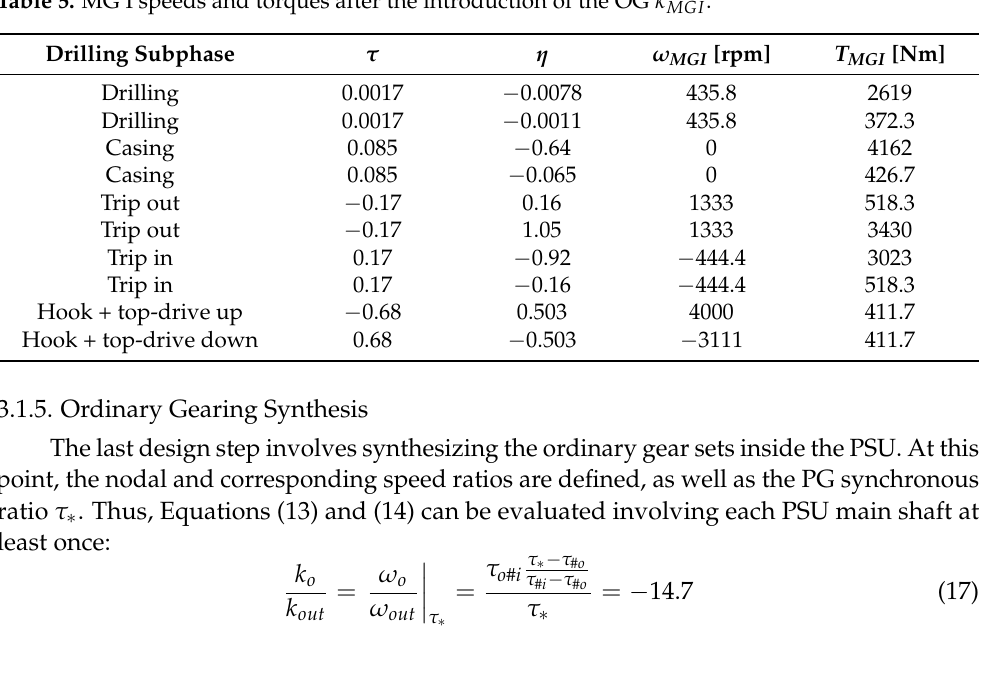
Table 5. MG I speeds and torques after the introduction of the OG k MGI